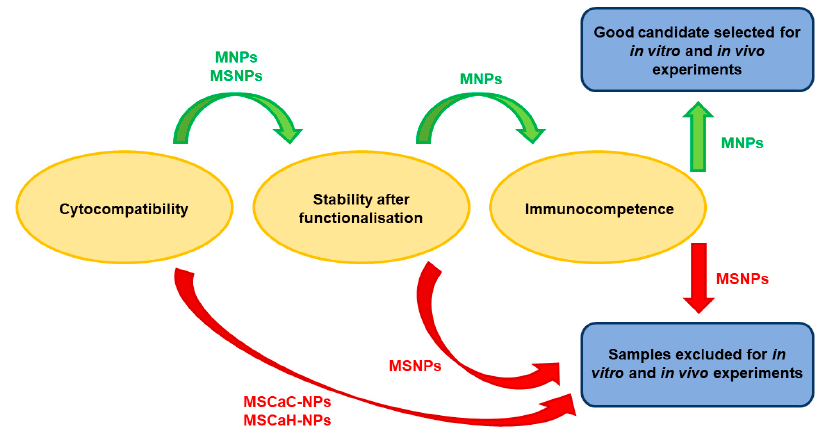
Figure 6. Selection of the best performant nanoparticle.